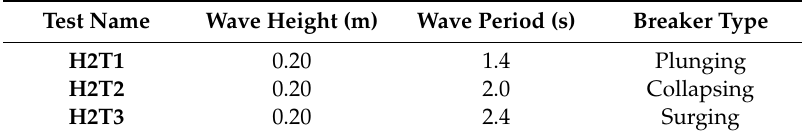
Table 1. Calibrated regular wave conditions for the image processing